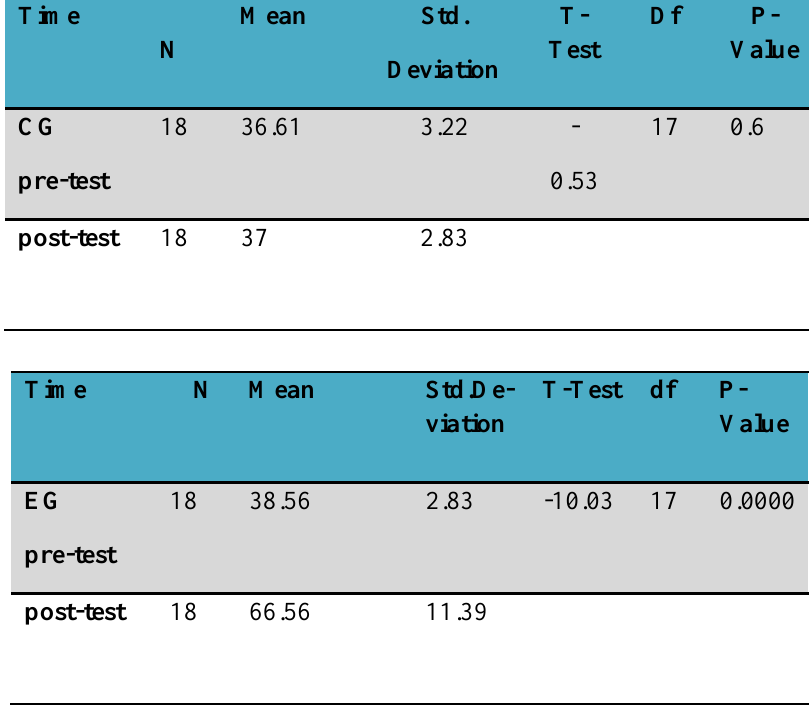
Table 1. Paired T-Test of